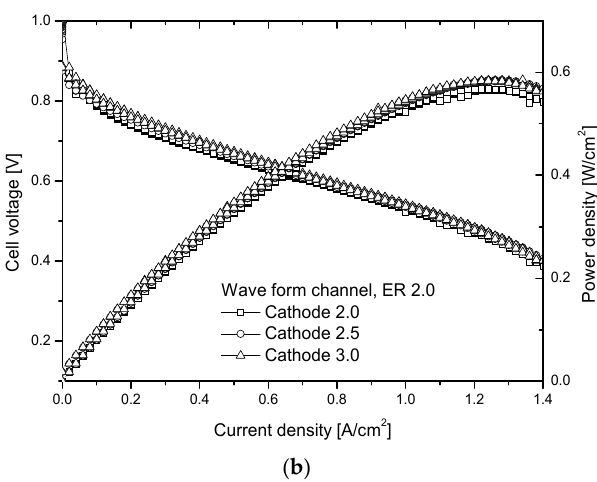
Figure 12. Pressure curve according to variation in stoichiometry at the cathode of ( a ) the normal channel and ( b ) wave form channel, ER 2.0.